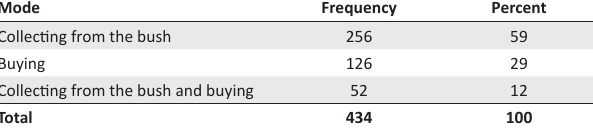
TABLE 2: Mode of firewood acquisition. Mode